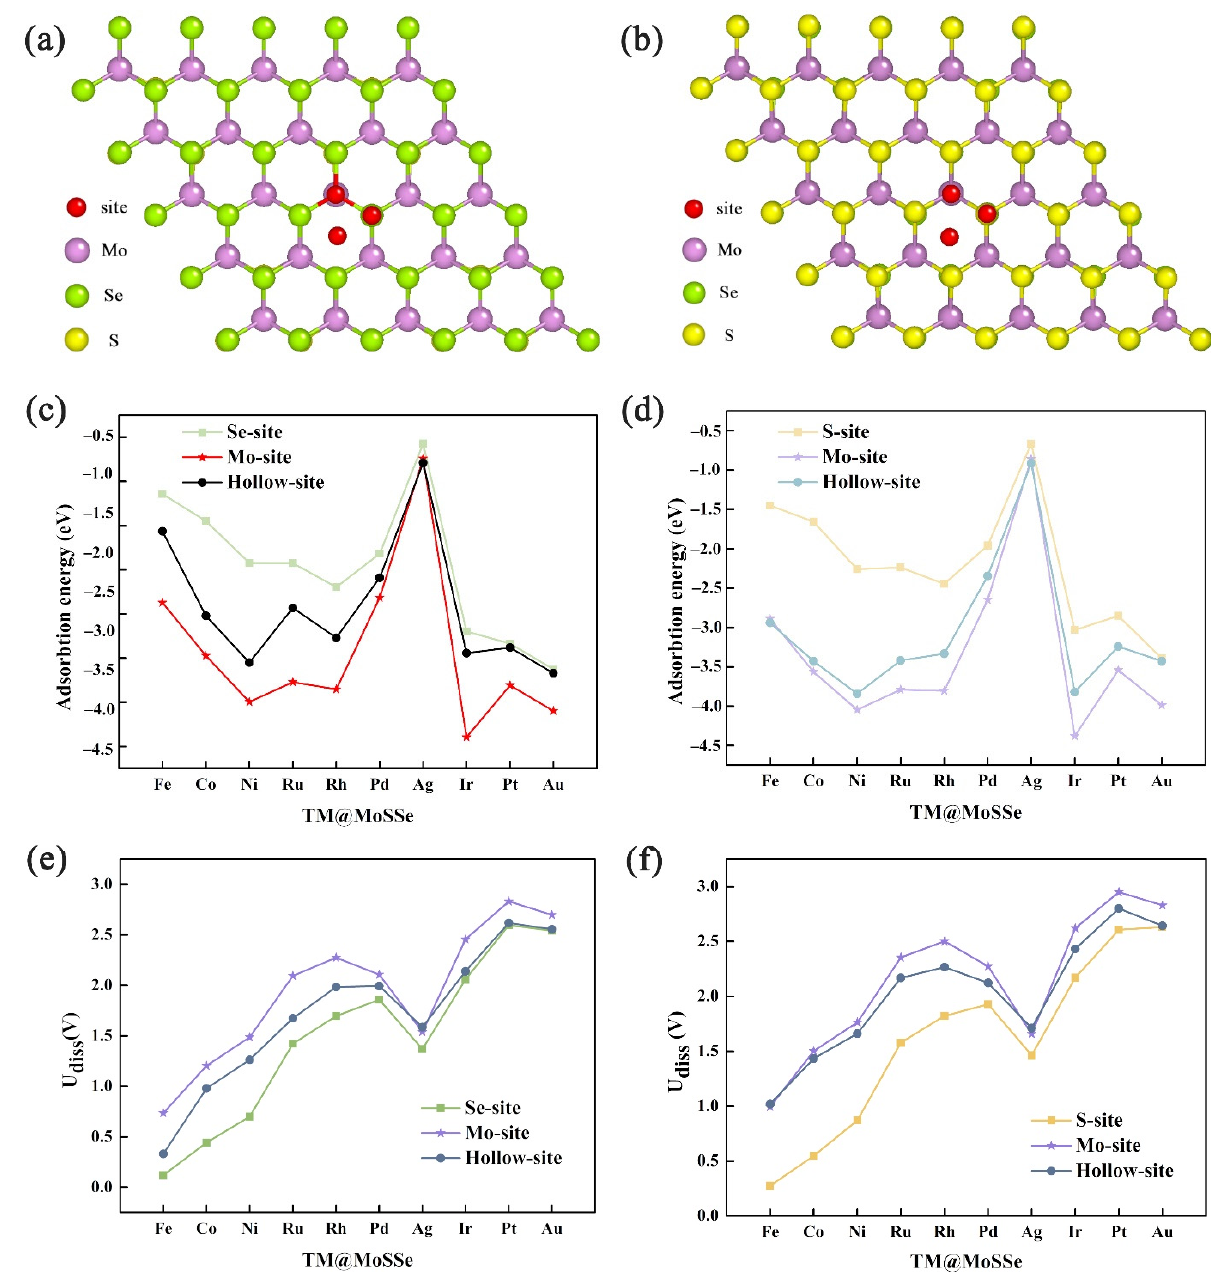
Figure 1. Adsorption structure of TM atoms anchored on ( a ) the S side of MoSSe and ( b ) the Se side of MoSSe, where purple, yellow, green and red balls represent the Mo, S, Se and TM. Adsorption energies of different TM atoms on ( c ) the Se side of MoSSe and ( d ) the S side of MoSSe. Dissolution potentials of different TM atoms on ( e ) the Se side of MoSSe and ( f ) the S side of MoSSe.